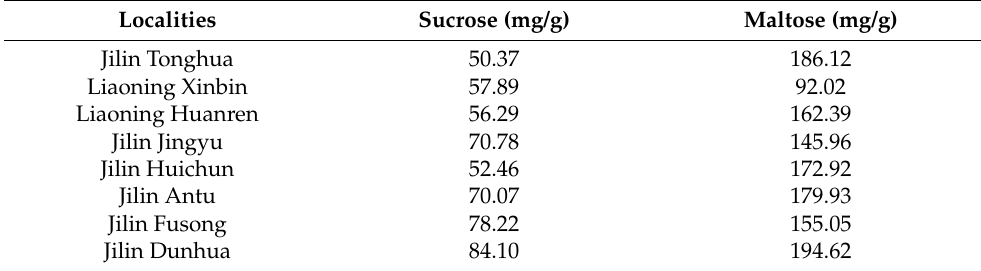
Figure 1. HPLC–ELSD chromatograms of blank solvent, mixed references ( A ) RG sample; ( B ) PCA of RG samples from different origins; ( C ) 1, sucrose; 2, maltose. Table 1. Results of determination of sucrose and maltose in RG.